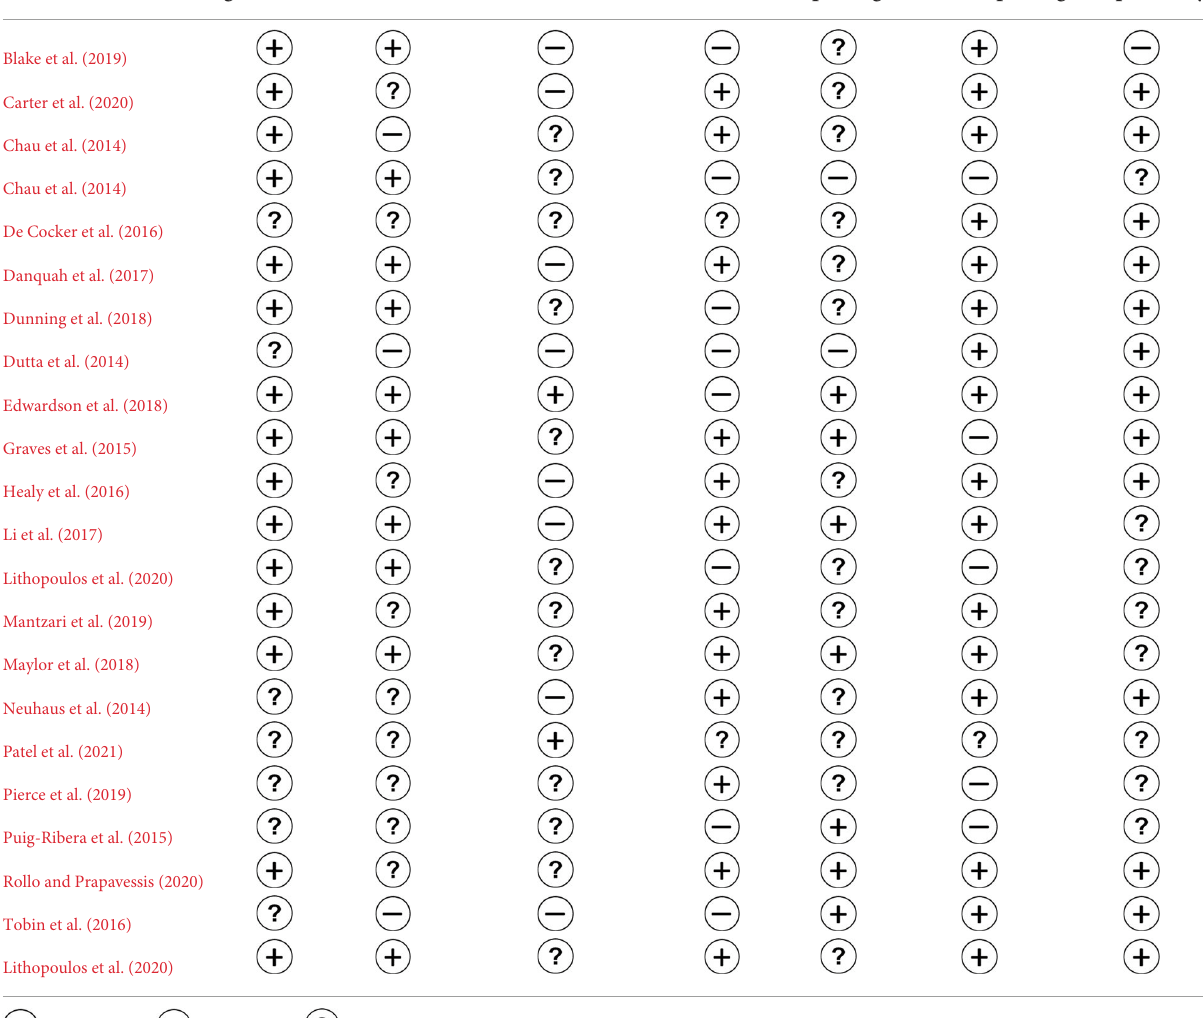
TABLE 3 Risk of bias summary by